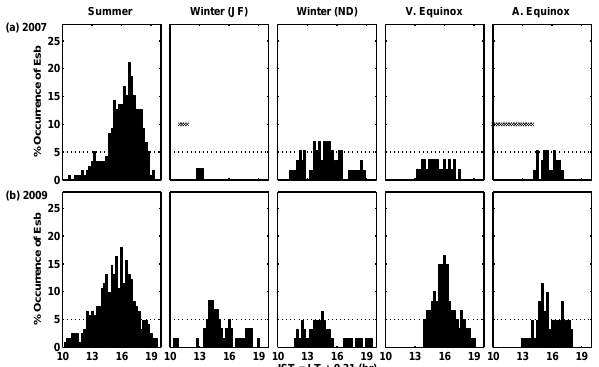
Figure 2. Seasonal percentage occurrence of E sb events as a func- tion of IST during (a) 2007 and (b) 2009. The cross symbols indi- cate data loss on more than 25% quiet days during that time bin. Horizontal dotted line represents 5% occurrence of E sb